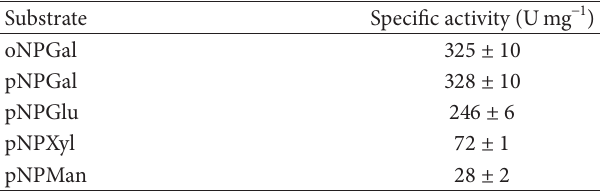
Table 1: Hydrolytic activity of Asac 1390 with different